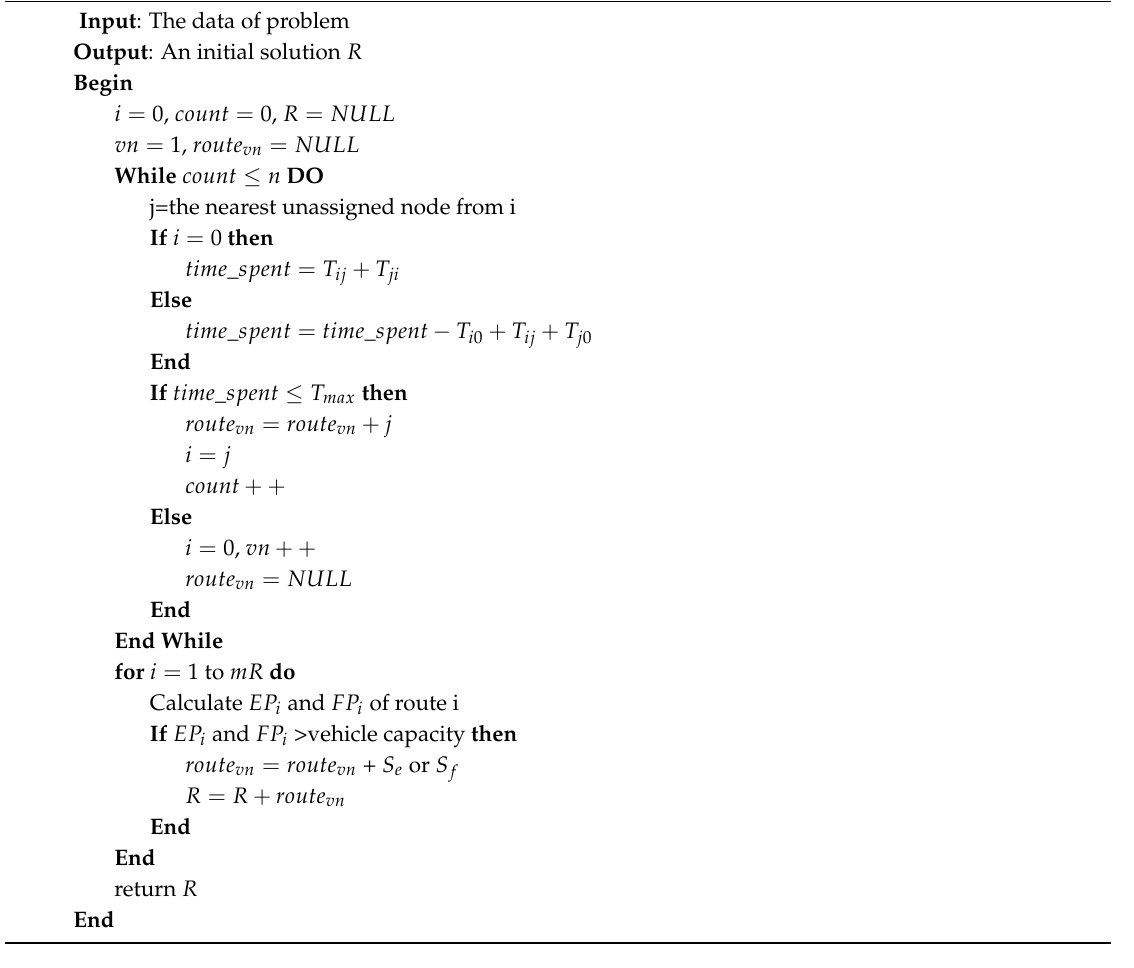
Algorithm 3: Method to generate a signal individual